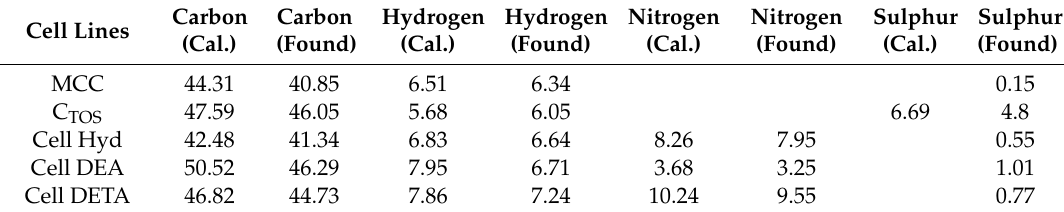
Table 1. Characterization of cellulose amine derivatives elemental analysis) (C, H, N,